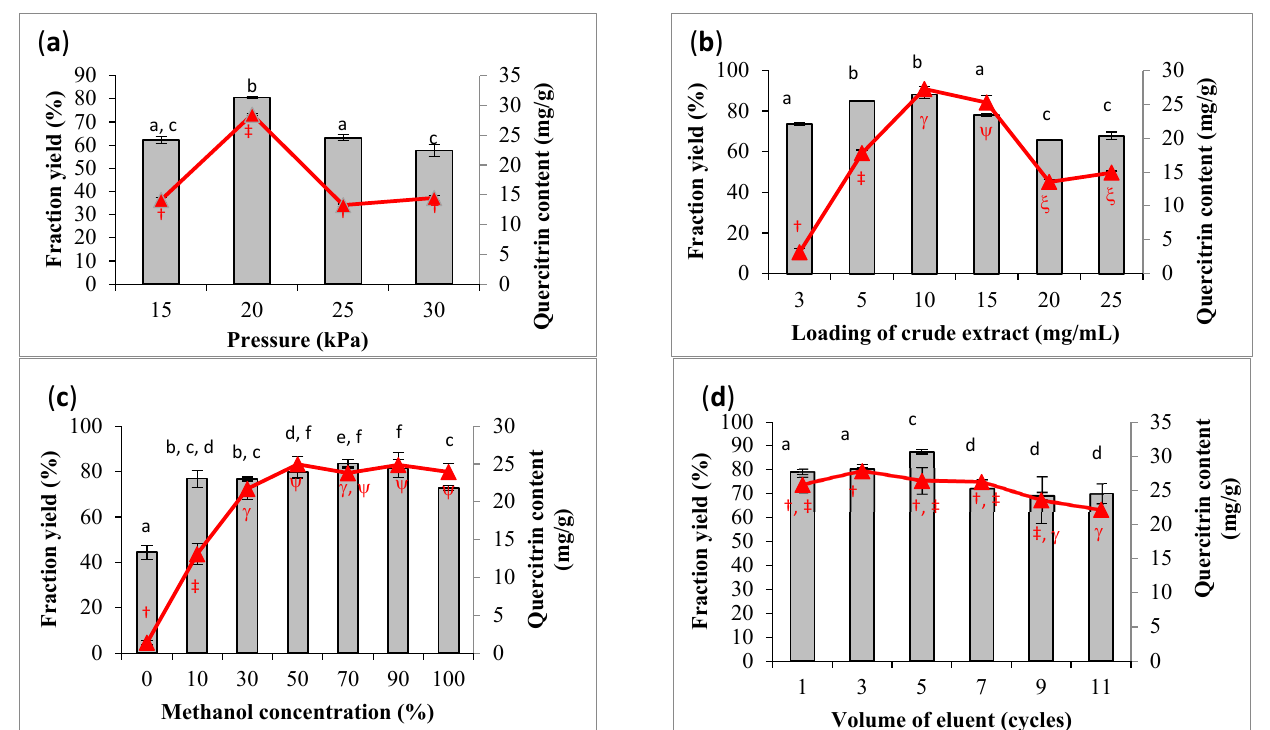
Figure 3. Screening parameters for high fraction yield (bar) and quercetrin content (line) based on one-factor-at-a-time (OFAT) approach. The screened parameters are ( a ) pressure (15–30 kPa), ( b ) loading concentration of crude extract (3–25 mg/mL), ( c ) methanol concentration (0–100%), and ( d ) volume of eluent expressed in number of cycles (1–11). Results are expressed in mean ± standard deviation of triplicate data. The mean values are significantly different if they do not share the same letter (bar) or symbol (line).